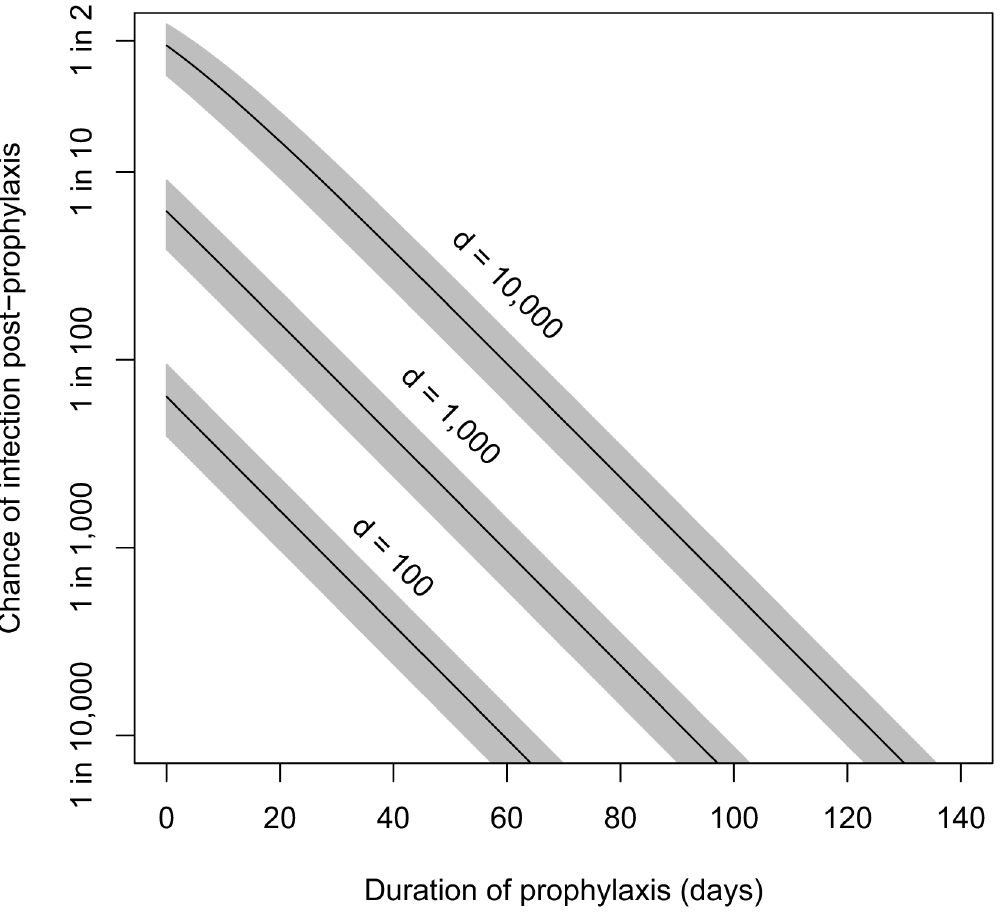
Figure 5. Estimated relationship between duration of prophylaxis and subsequent chance of infection. Relationship between duration of prophylaxis (days, post-exposure) and the estimated chance of infection after antibiotics are no longer taken, at doses of 100, 1,000, and 10,000 spores. We assume the probability-per-day for clearance of spores from the lung, h , is 0.07, and shaded areas are the confidence regions based on the 95% confidence interval for model B4 ’s fitted parameter r (probability of one spore germinating before being